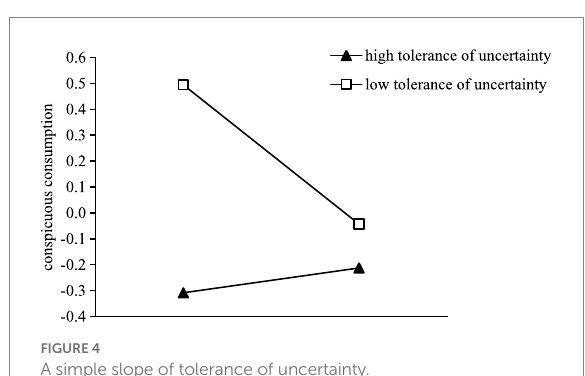
FIGURE 4 A simple slope of tolerance of uncertainty.